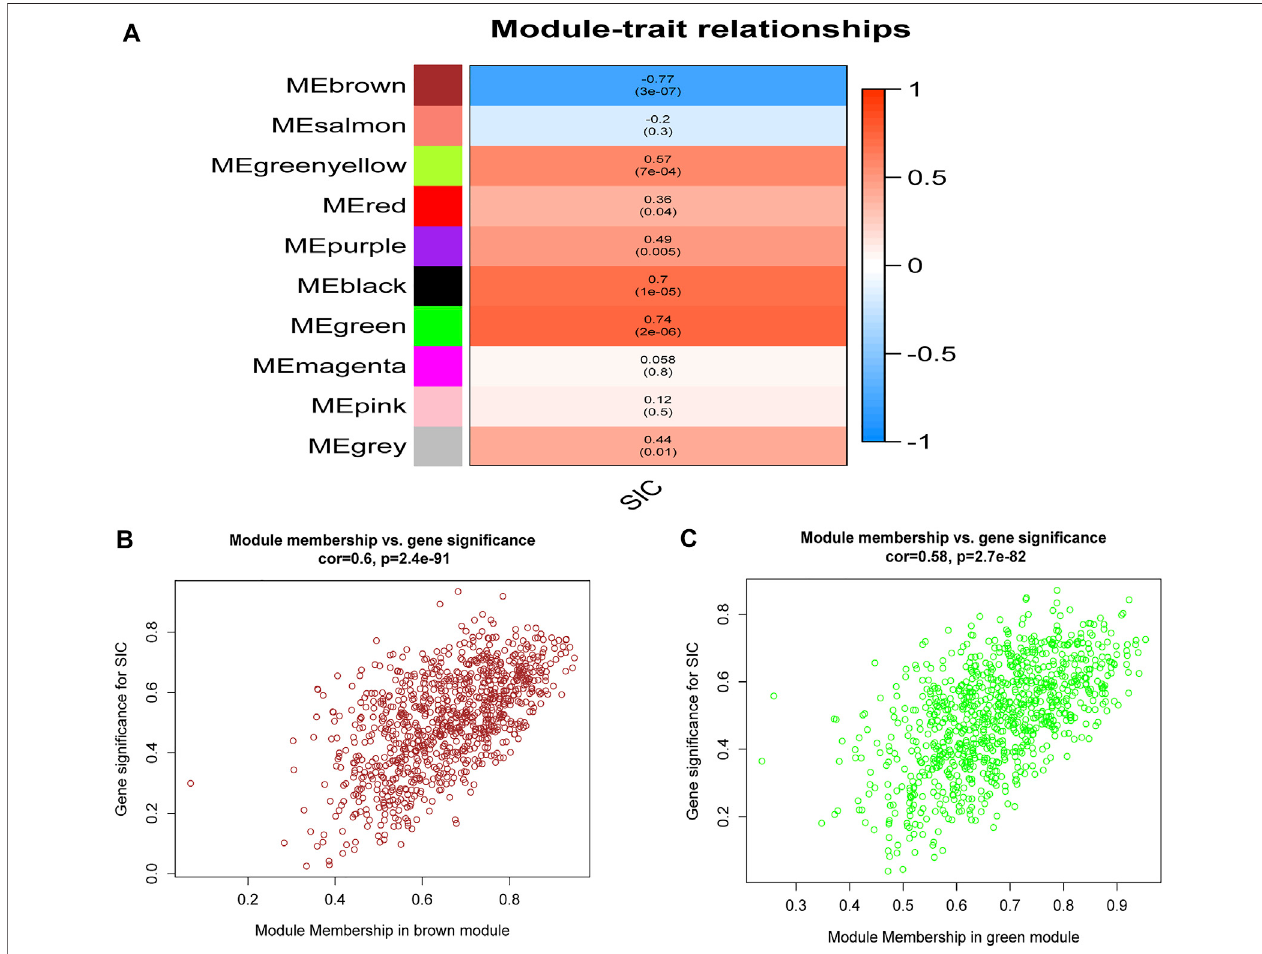
FIGURE2| Relationshipsofmodule-trait. (A) HeatmapshowingtheconnectionoftheseparatemoduletoSIC.Correlationcoef fi cientsand p valuesareincludedin themodules.RedmeansastrongpositiverelationshipofthismoduletoSIC,whilebluerepresentsastrongnegativerelationship. (B) GSforSICofthebrownmoduleand each dot means a gene of this module. (C) GS for SIC of the green module and each dot represents a gene in this module. GS: Gene signi fi cance. SIC: sepsis-induced cardiomyopathy.